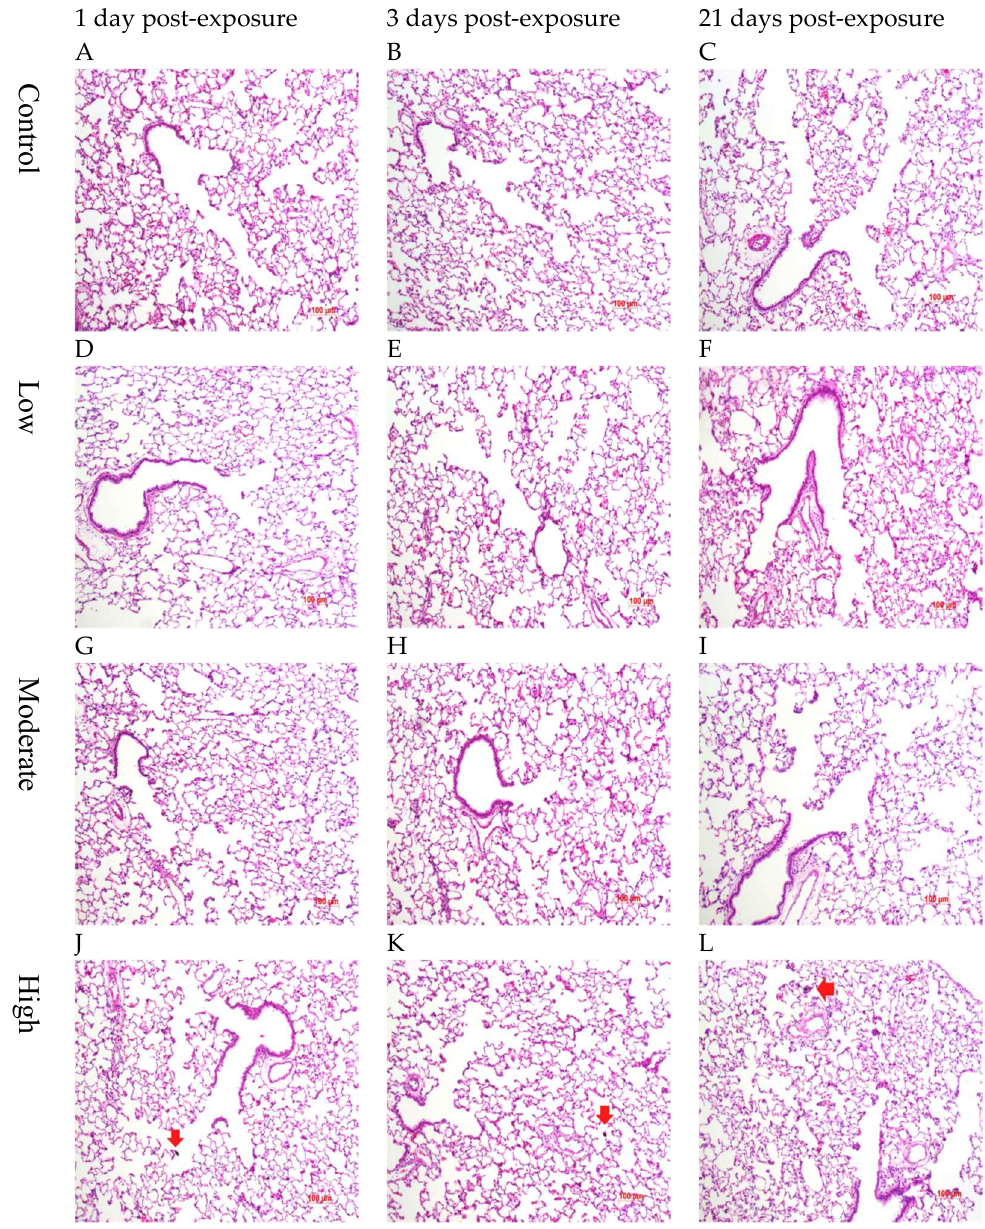
Figure 6. Lung histopathology of male rats at 1, 3, and 21 days after CNF exposure; arrows: alveolar macrophages with ingested CNFs (×100).